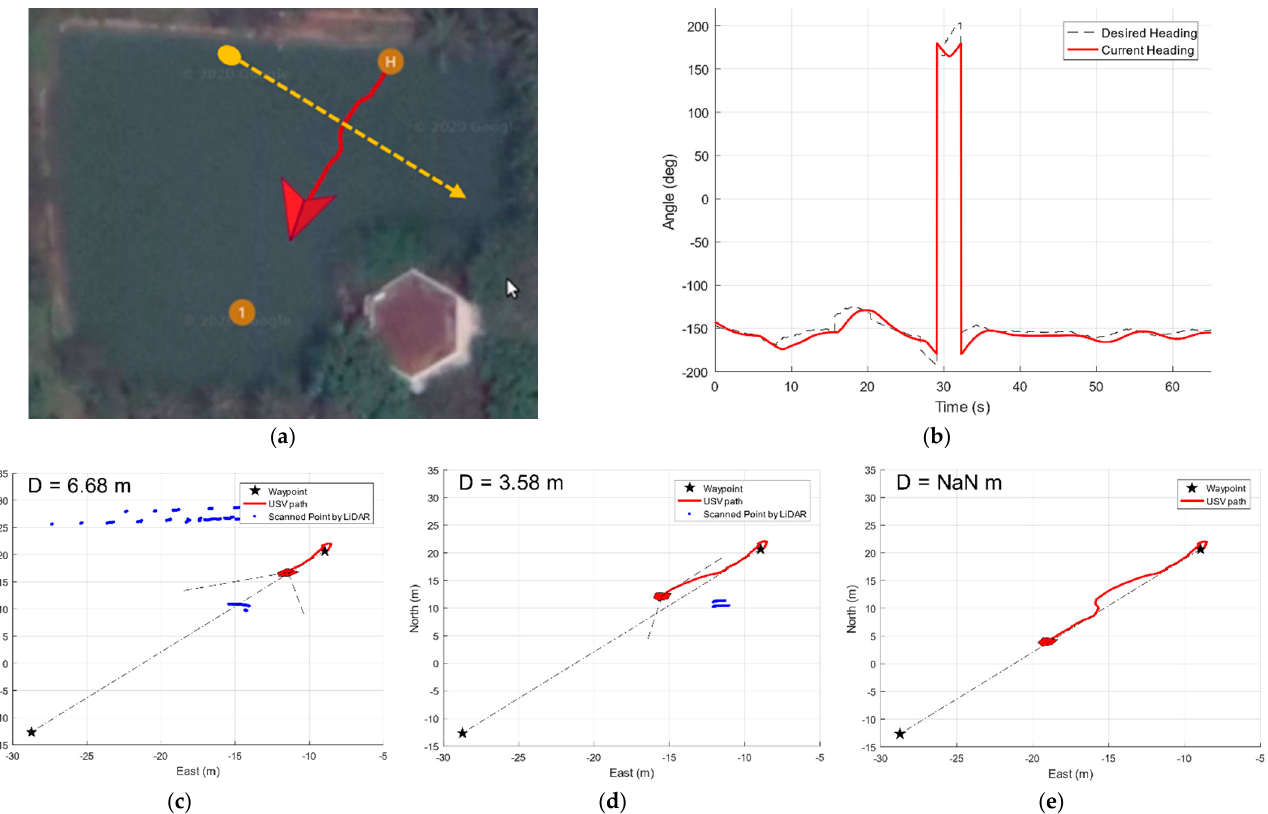
Figure 20. Dynamic obstacle avoidance in case of crossing: USV2000 ′ s path (red) and obstacle’s path (yellow) are shown in ( a ); heading-tracking analysis in ( b ); obstacle avoidance process with evolving pair of avoiding directions (black) in ( c – e ).